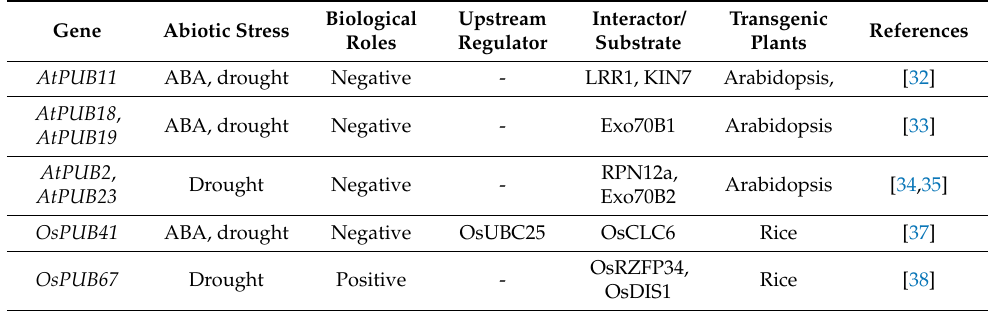
Table 2. PUBs Function as Positive or Negative Regulators in the Response to Abiotic